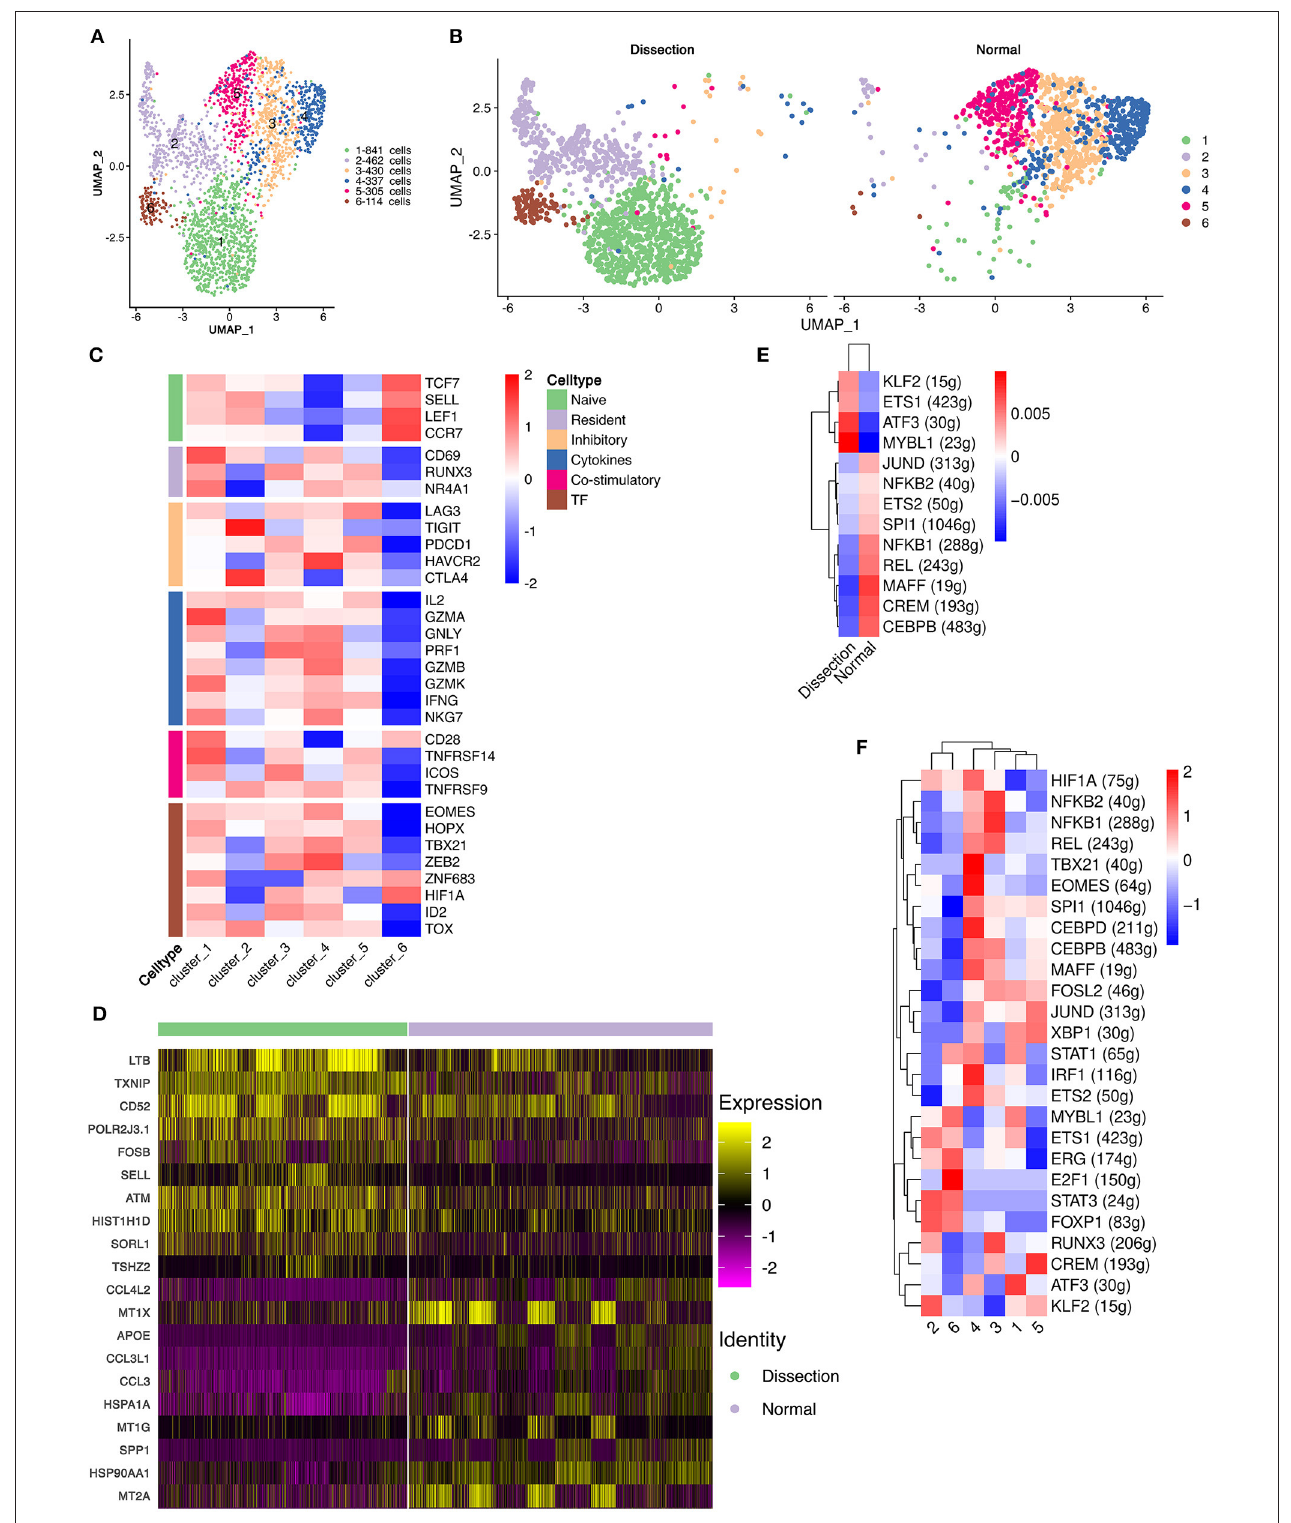
FIGURE 3 | Functional changes in CD4 + T cells in AD tissues compared to normal aorta tissues. (A) Reclustering of CD4 + T cells into 6 clusters, as shown by the UMAP plot. (B) A UMAP plot showing CD4 + T cells from the AD and NA groups. (C) Heatmap of different properties of CD4 + T cells as identified by corresponding canonical markers. (D) Heatmap of the top 10 [by average log (fold change)] marker genes in CD4 + T cells in the AD and NA groups. (E,F) SCENIC analysis of the top differentially expressed transcription factors among different groups (E) or clusters of T cells (F) . AD, aortic dissection; NA, normal aorta; UMAP, uniform manifold approximation and projection for dimension reduction; SCENIC, single-cell regulatory network inference and clustering.